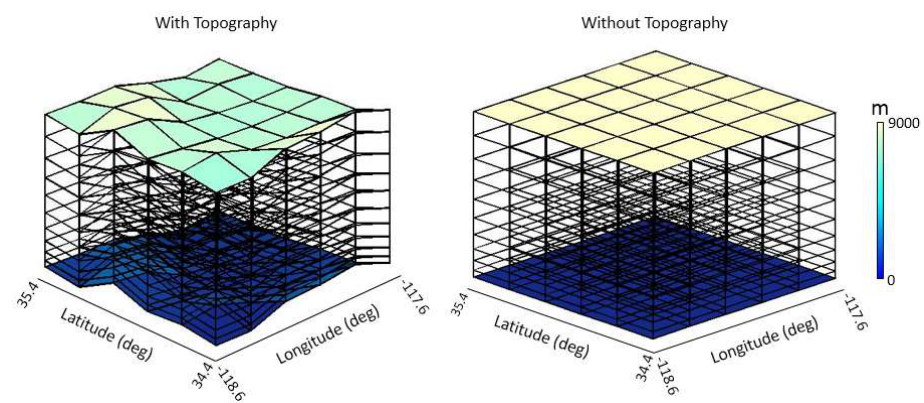
Figure 6. Considered basic tomography models for this study.